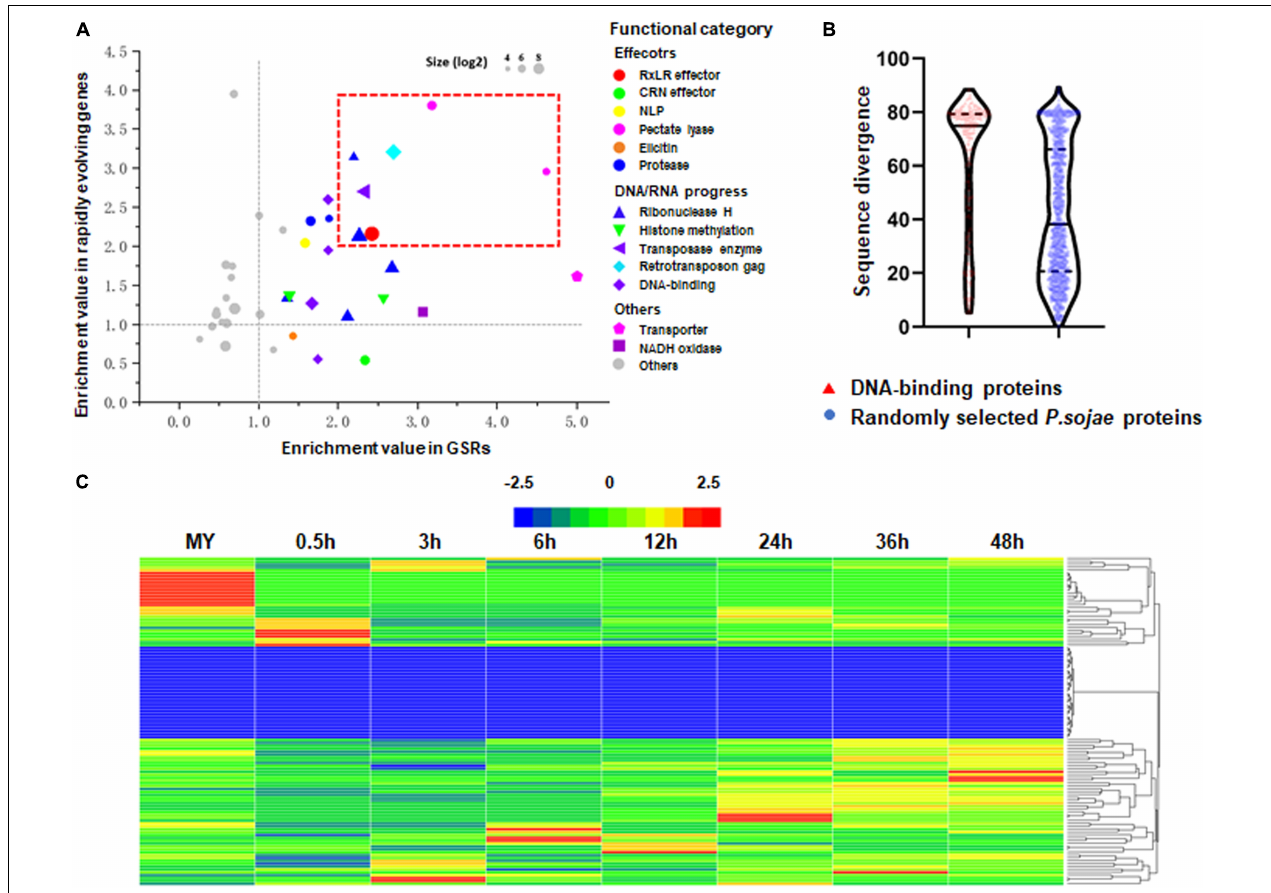
FIGURE 3 | High correlation of genes density and evolving speed. (A) Enrichment index in GSRs ( x axis) and rapidly evolving genes ( y axis). The top 40 enrichment gene families are shown as the indicated colored bubbles. Bubble sizes are proportional to the sizes of gene families. (B) Violin plot visualization of sequence divergence of genes encoding DNA-binding proteins and randomly selected genes between P. sojae and P. ramorum . Gene sequence divergence is defined as one minus sequence identity. Red bar indicates genes encoding DNA-binding proteins. Blue bar indicates randomly selected genes as controls. (C) Hierarchical clustering of transcriptional patterns for genes encoding DNA-binding proteins in P. sojae. Z score normalization was applied for the transcription levels of genes at all stages. Cluster analysis was performed using the Heml